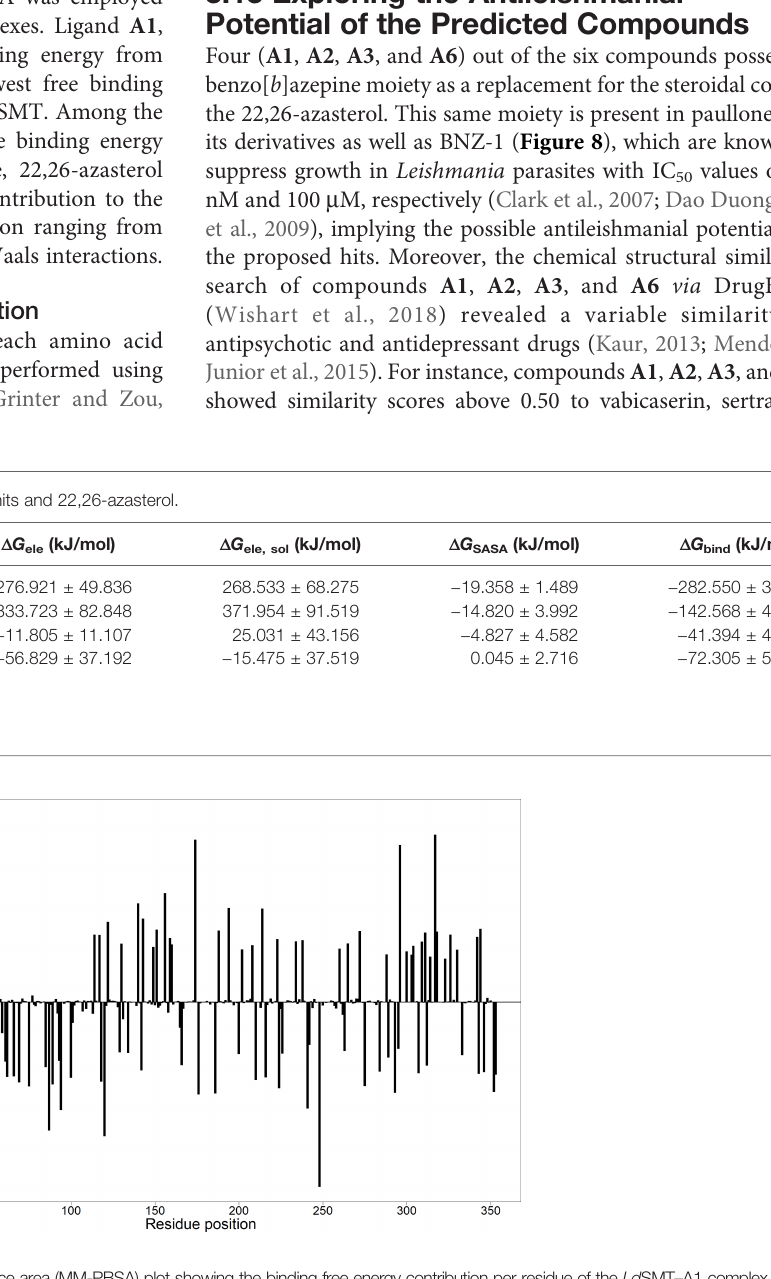
FIGURE 7 | Molecular mechanics Poisson – Boltzmann surface area (MM-PBSA) plot showing the binding free energy contribution per residue of the Ld SMT – A1